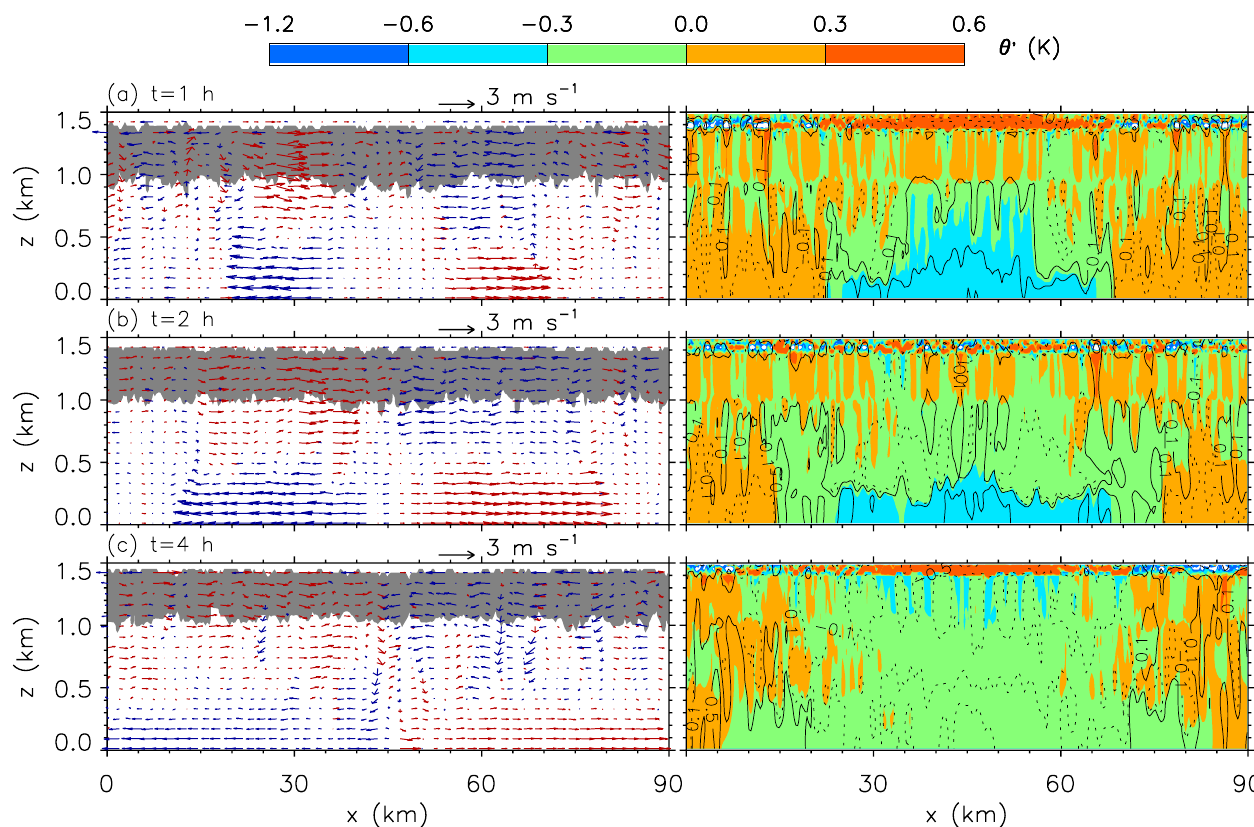
Fig. 7. The x-z cross-sections (at y=45km) from experiment PQVT at (a) – (c) t =1, 2 and 4h. Left: Gray shaded areas denote clouds (cloud water mixing ratio > 0.01gkg − 1 ); arrows represent wind perturbations ( u − w) with red for westerly ( u> 0) and blue for easterly ( u< 0) to demonstrate the outflow at the lower-level and return flow at the upper-level associated with the negative temperature perturbation in the middle of the domain (originally between x =30 and 60km). Right: Shaded colors indicate temperature perturbations, and contours, water vapor mixing ratio perturbations (positive by solid lines and negative by dotted lines); perturbations are relative to the horizontal slab average at each